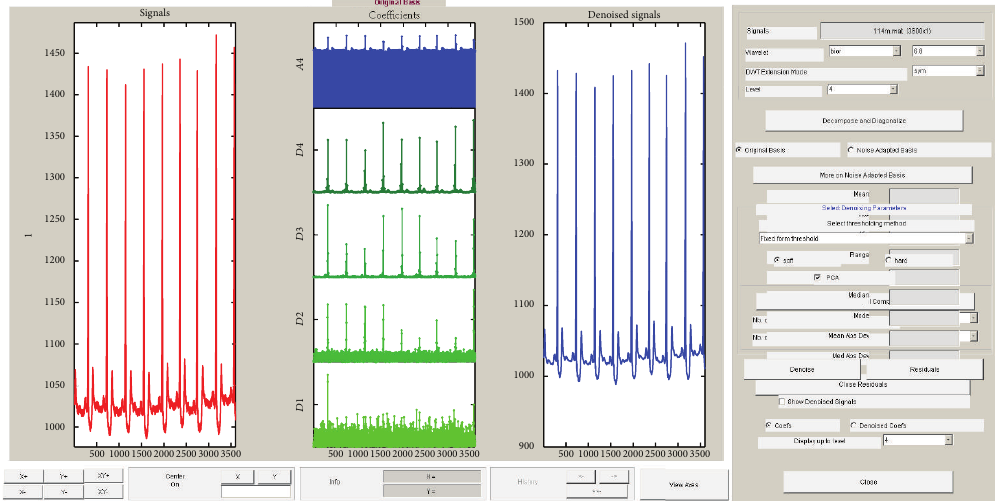
Figure 7: Multiwavelet denoising for ECG record no 114m using Biorthogonal 1D wavelet.